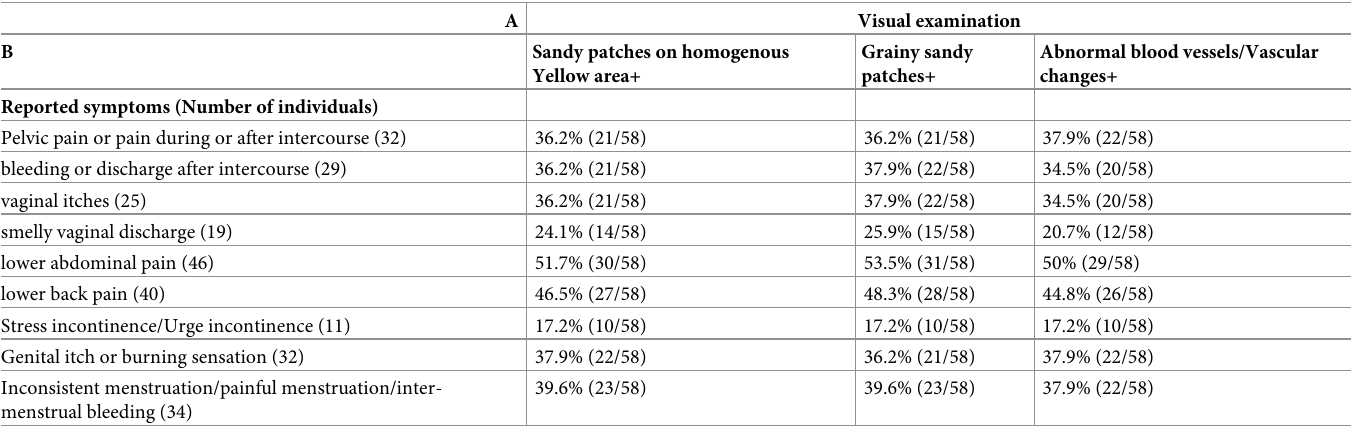
Table 4. Summary of self-reported symptoms with confirmation by visual examination by colposcopy.